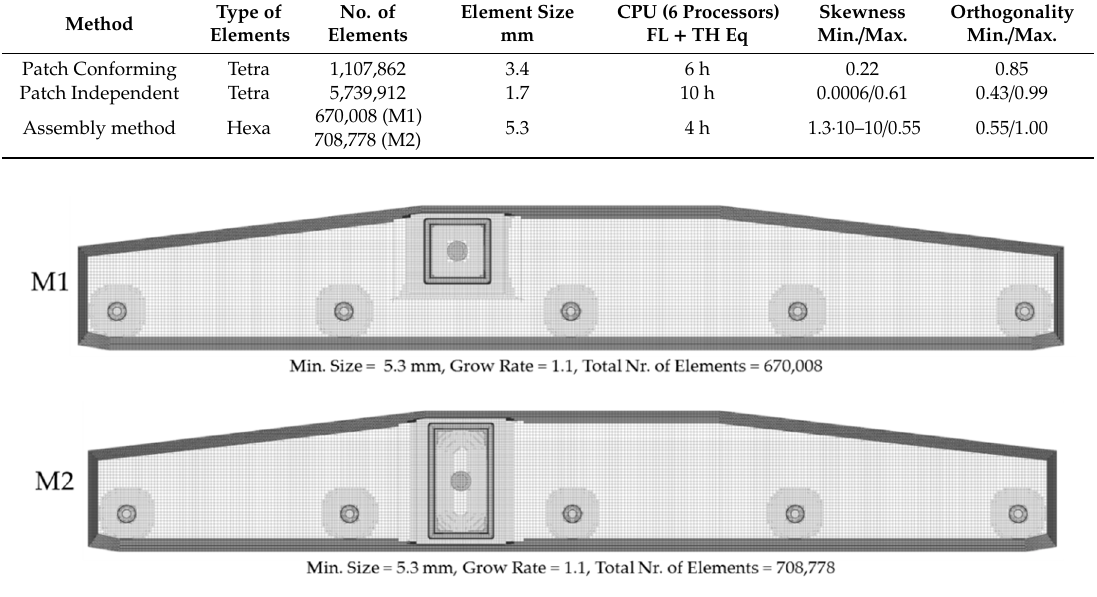
Figure 3. Final computational meshes prepared by Assembly Method with Cut Cell.